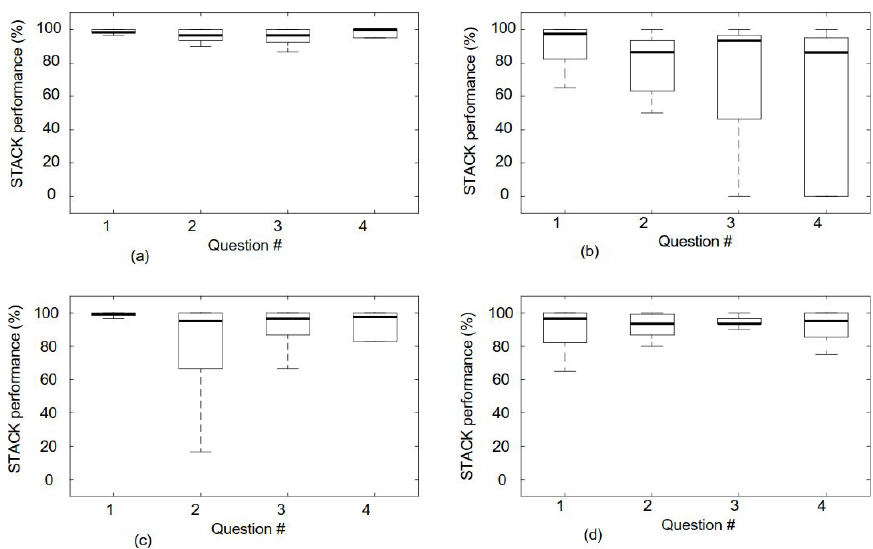
Fig. 4. Boxplot of the preliminary e-exam performance for a) the passed (N=25), b) the failed (N=16), c) ‘honest’ (N=26) and d)’less-honest’ (N=15)